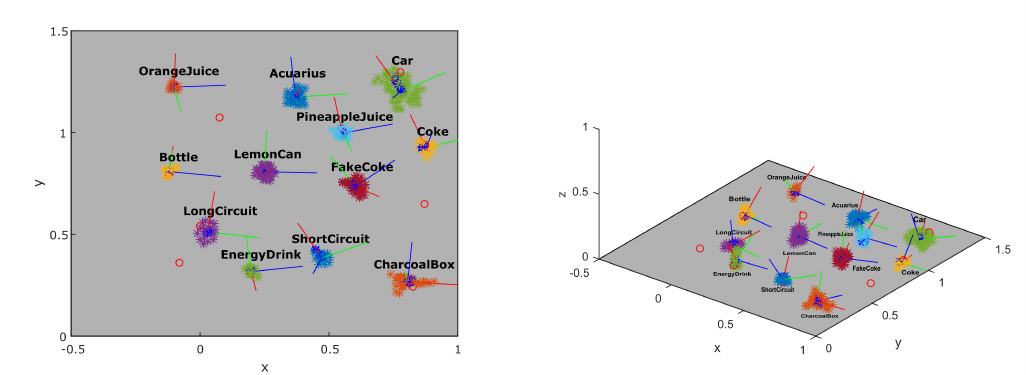
Figure 13. Reconstruction of the objects in the scene ( colored clusters) compared to ground truth ( red circles). The frame in each object represents the PCA (principal component analysis) results with the red axis representing the dominant axis.